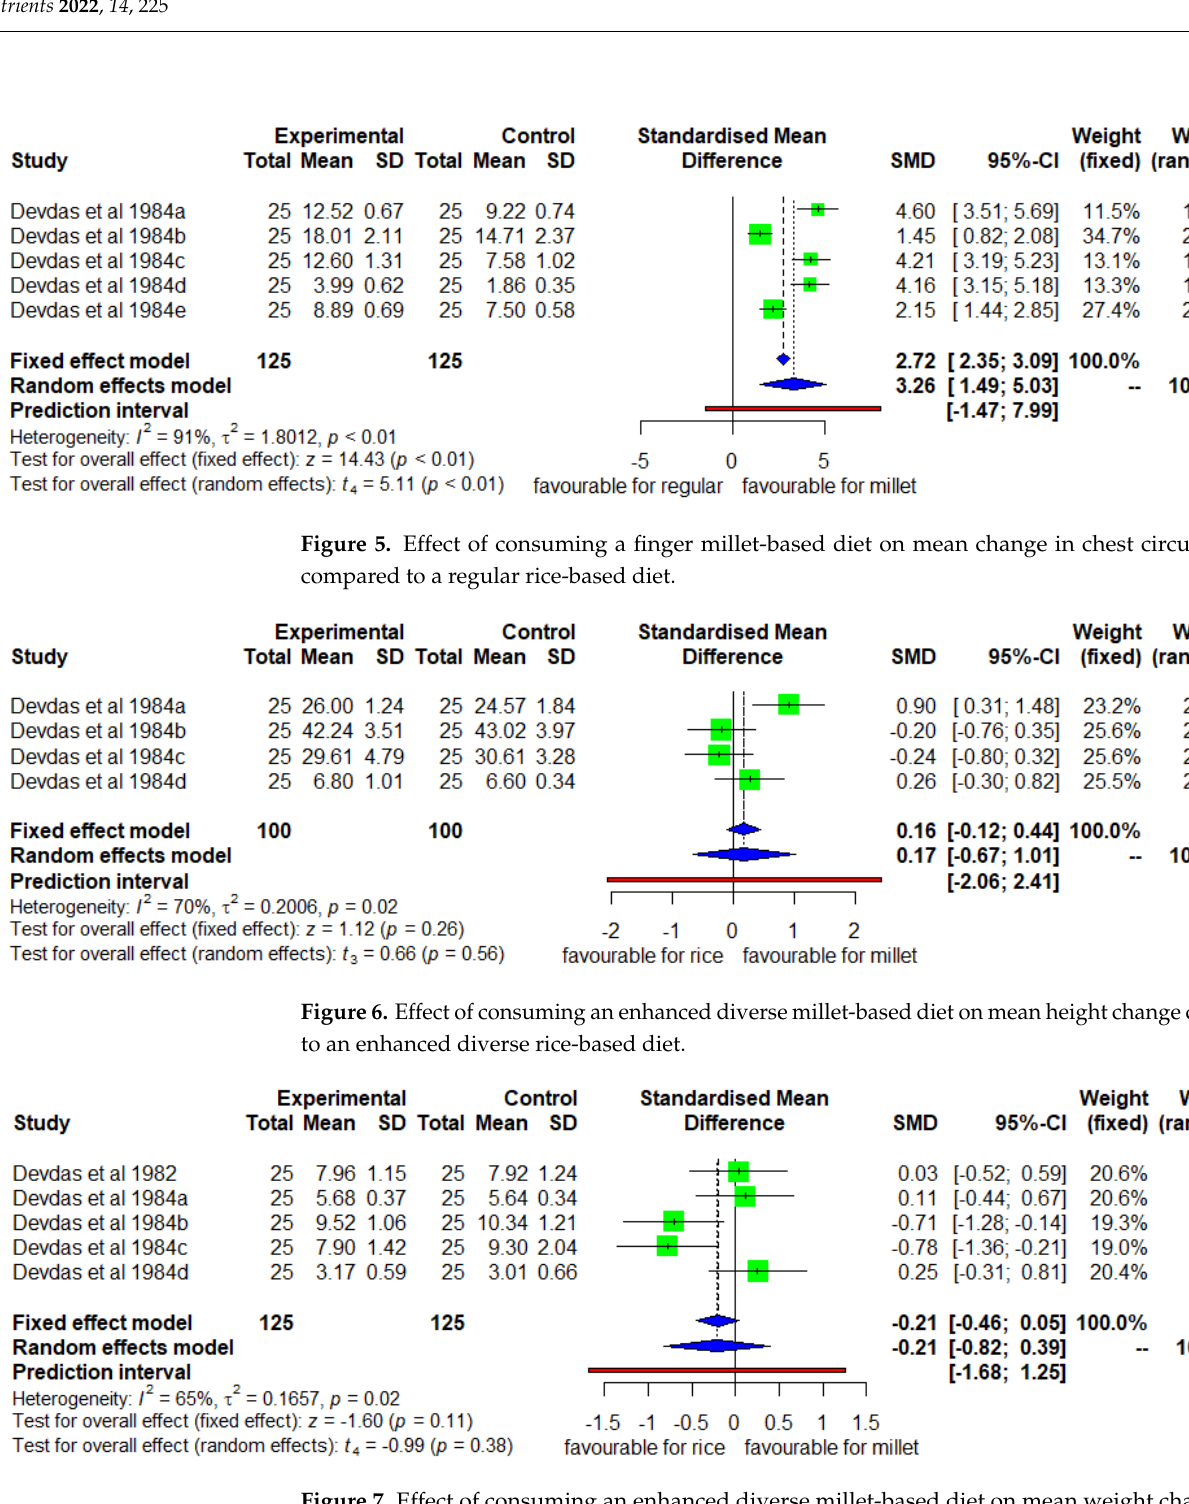
Figure 7. Effect of consuming an enhanced diverse millet-based diet on mean weight change com- pared to an enhanced diverse rice-based diet.